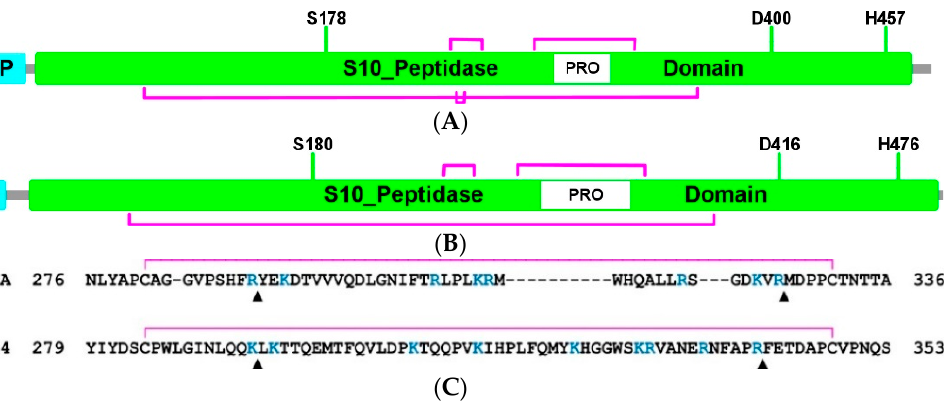
Figure 2. Illustration of the primary structure of hPPCA ( A ) and Nf 314 ( B ). The signal peptide (SP, cyan) and the serine carboxypeptidase domain (S10_peptidase, green) are shown in boxes, as is the propeptide region (PRO, white) inside the latter. It also indicates the disulfide framework and the relative location of the catalytic triad. ( C ) Prediction of the Nf 314 propeptide by sequence comparison with hPPCA. Pairwise alignment highlighting the Arg/Lys residues (R/K, blue font), usually recognized by trypsin-like proteases. The propeptide processing sites, identified for hPPCA and predicted for Nf 314, are indicated with black triangles (up-pointing). The disulfide bond opposite and adjacent to the PRO region is also delineated (magenta line).